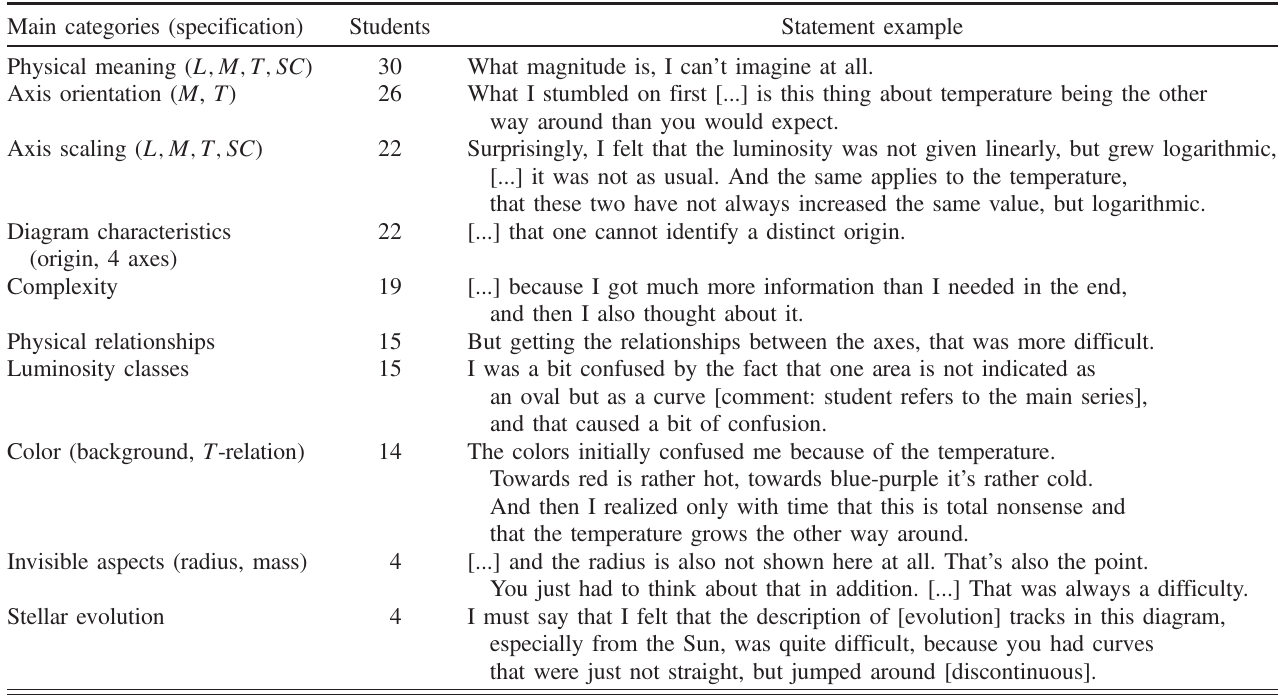
TABLE VI. Summary of perceived learning difficulties in using the HRD. A category was counted only once per student, even if multiple statements were made about it. Thus, the count of students (out of 35) who commented on a category is provided. Main categories